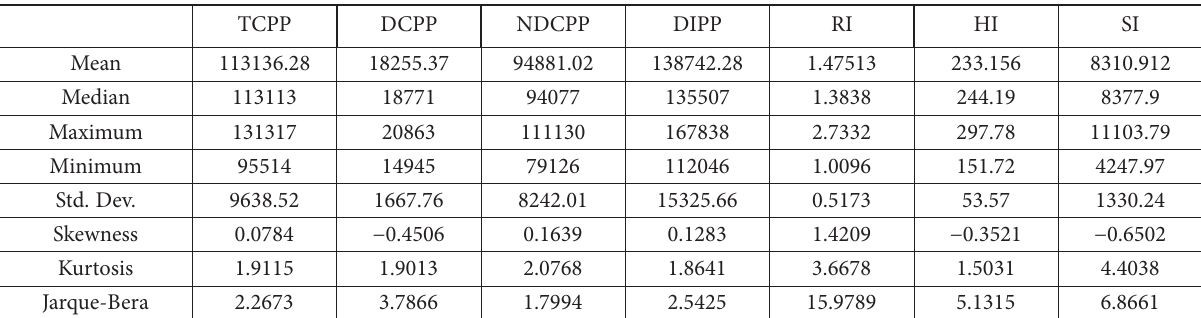
Table 2. Descriptive statistics for main categories of consumption, and disposable